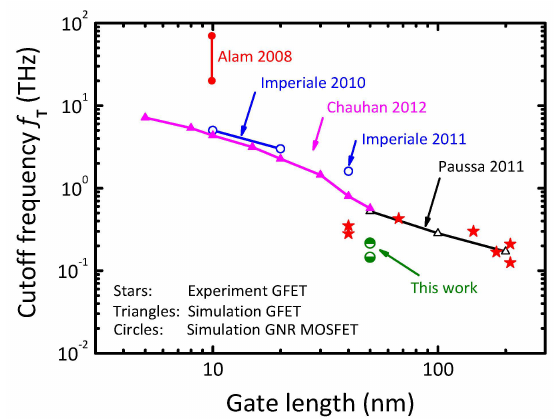
Figure 11. Simulated cutoff frequency of GNR MOSFETs and GFETs as a function of gate length. Data taken from the literature [21,22,47,48] and from the present work. f T data of experimental GFETs and data taken from the compilations in are also shown [5,6]. The two data points designated by this work correspond to the cutoff frequency of the single-channel GNR MOSFETs, see also Figure 6a, and of the multiple-channel GNR MOSFET with a GNR separation of 5 ˆ w